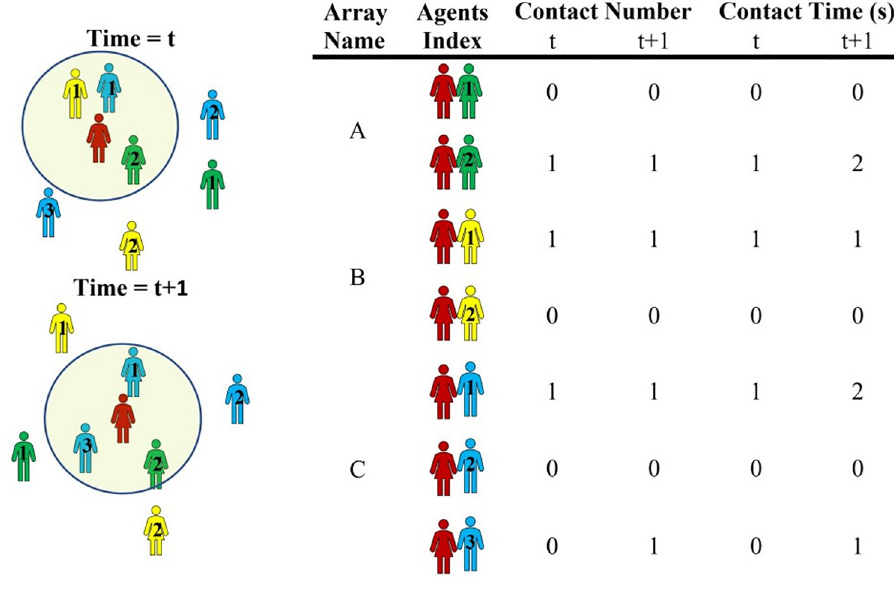
Fig 4. Contact array at two successive